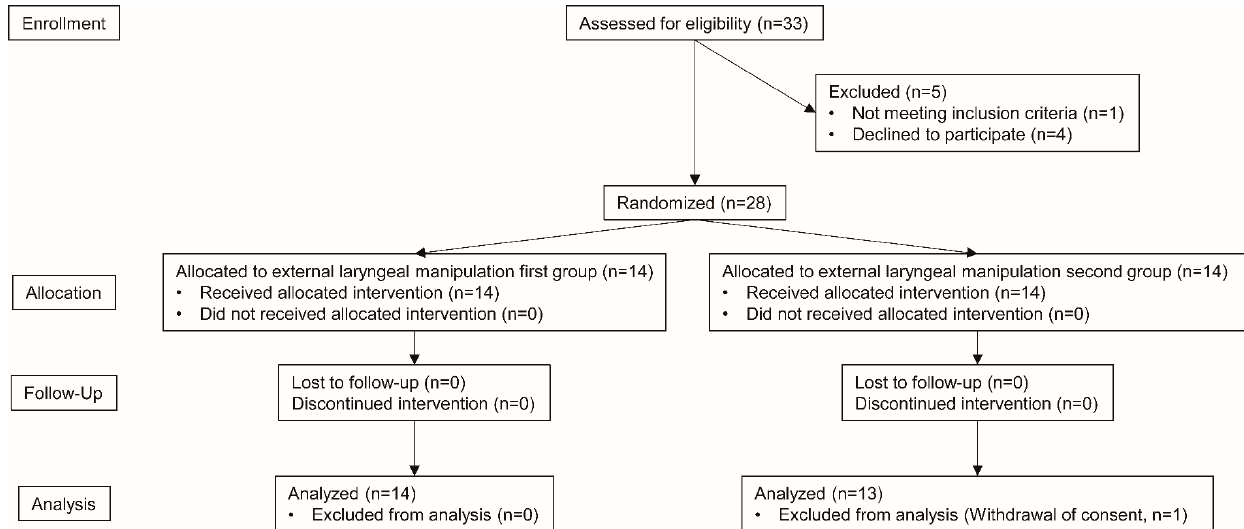
Figure 2. Consolidated Standard of Reporting Trials diagram. Table 1. Patient characteristics.